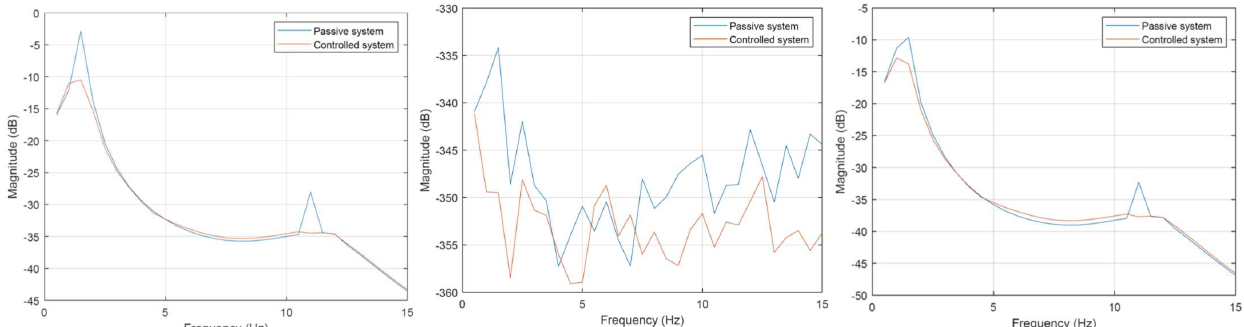
Figure 13. Vibration transmissibility characteristics for excitation of the middle axis for both wheels simultaneously. Displacement of the center of mass—left characteristic, pitch angle—central characteristic, roll angle—right characteristic.